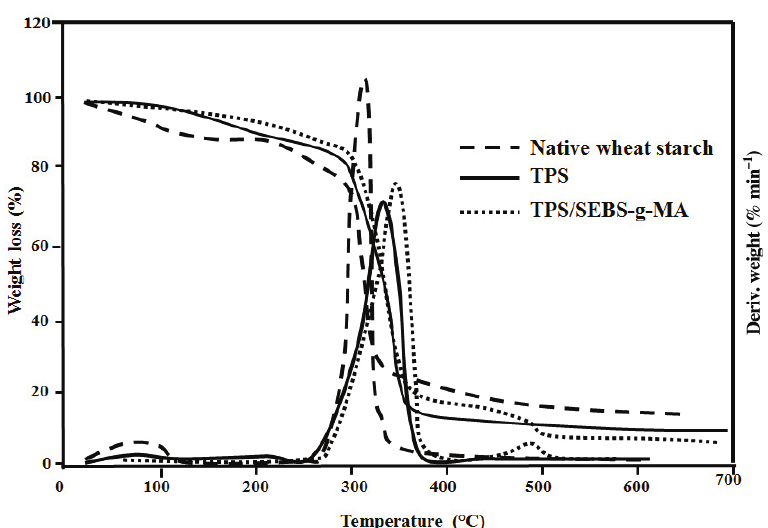
Fig. 6 – TG/DTG curves of native wheat starch, TPS and